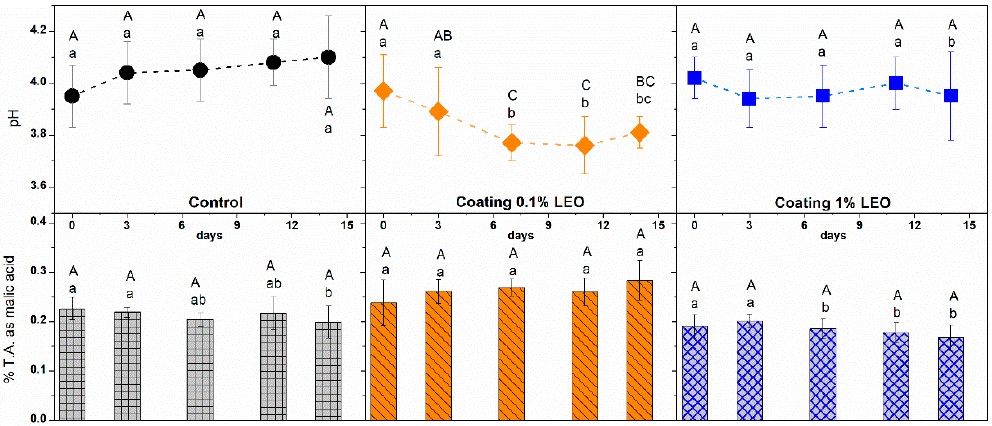
Figure 4. pH (upper panels) and titratable acidity (lower panels) of fresh-cut apples with different treatment during storage at 4 °C. Means with the same letters (lowercase: amongst different treatments for the same time; uppercase: for the same treatment during different storage times) are not significantly different according to Tukey’s test ( p > 0.05). Vertical bars indicate standard deviation.